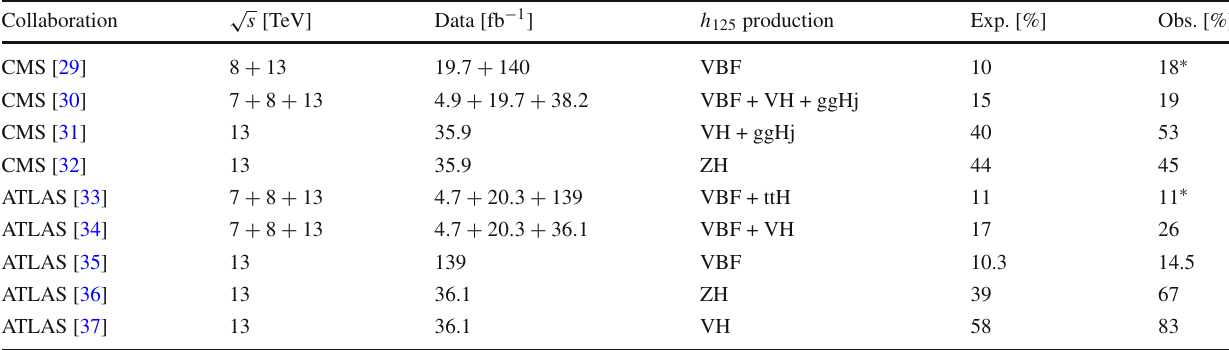
Table 1 Expected (exp) and observed (obs) experimental upper limits star. The production modes of h 125 targeted in the different searches are vector-boson fusion (VBF), production in association with a Z -boson at the 95% confidence level on the invisible branching ratio of h 125 as (ZH) or Z - and W -bosons (VH), and gluon-fusion production in asso- reported by ATLAS and CMS, obtained from direct searches for the √ s = 13 TeV. The currently ciation with a jet (ggHj) invisible decay of h 125 at the LHC at strongest upper limit reported by each collaboration are marked with a